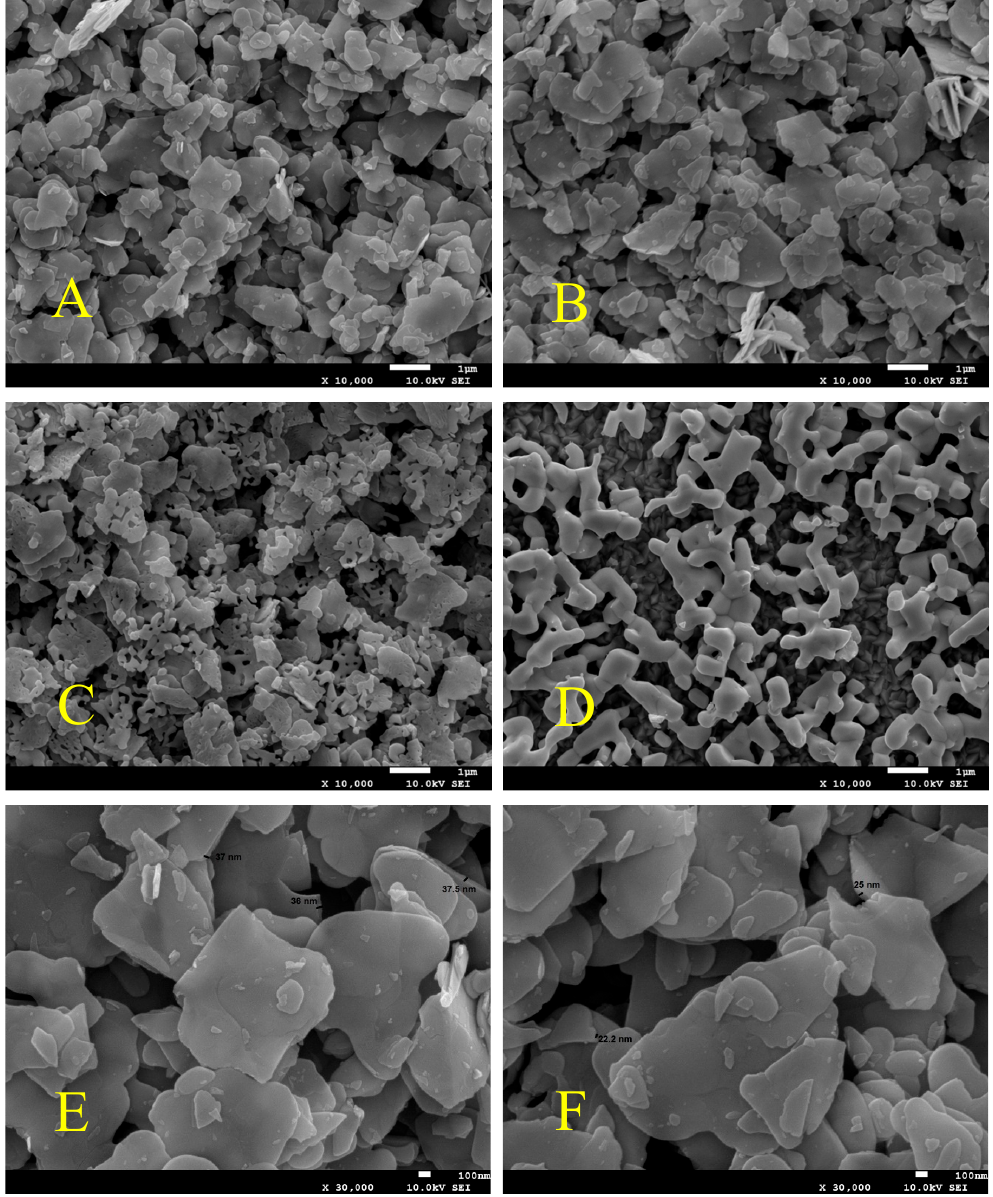
Figure 3. SEM images of annealed BiOI at different temperatures: 100 °C, 300 °C, 450 °C, 550 °C ( A – D ); and the higher magnification image of the annealed sample at 100 °C and 300 °C ( E and F ).